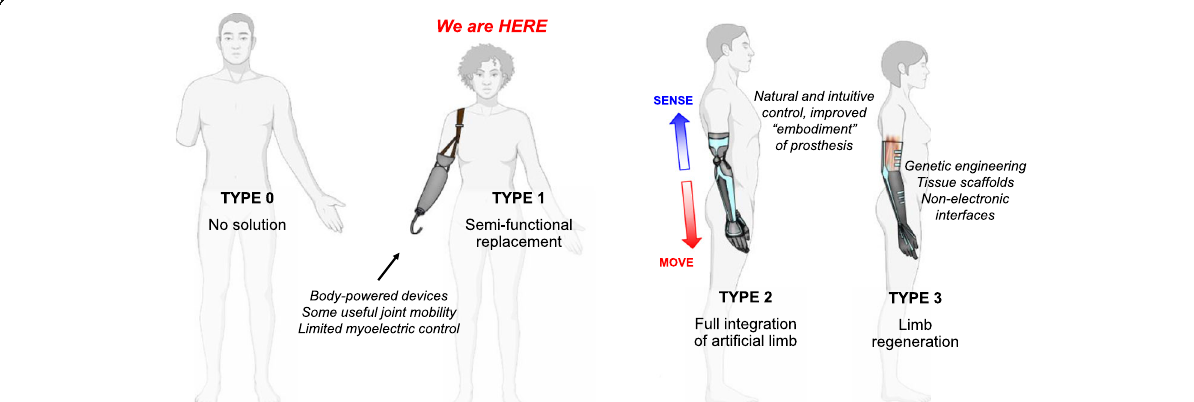
Fig. 1 The Evolution of Bioelectronics. When it comes to the development of bioelectronic devices, the evolution of these devices ’ use in medicine can be described with a scale based on Kardashev ’ s scale. A “ Type 0 ″ bionic species has no ability to treat neuromuscular damage with electronics. “ Type 1 ″ species are like modern humans. We can form stable mechanical interfaces with devices that partially replace the function of some nervous tissues. Passive bioelectronic devices like wearables, pacemakers, or cochlear implants have been adopted into mainstream medicine. Engineers are working to bring us closer to a “ Type 2 ″ species, in which bioelectronic devices that would previously have been considered “ active, ” requiring conscious input from the user to function, can become fully integrated into the human nervous system for intuitive control. “ Type 3 ″ species will have an even more harmonious integration of biology and technology, something that is likely beyond